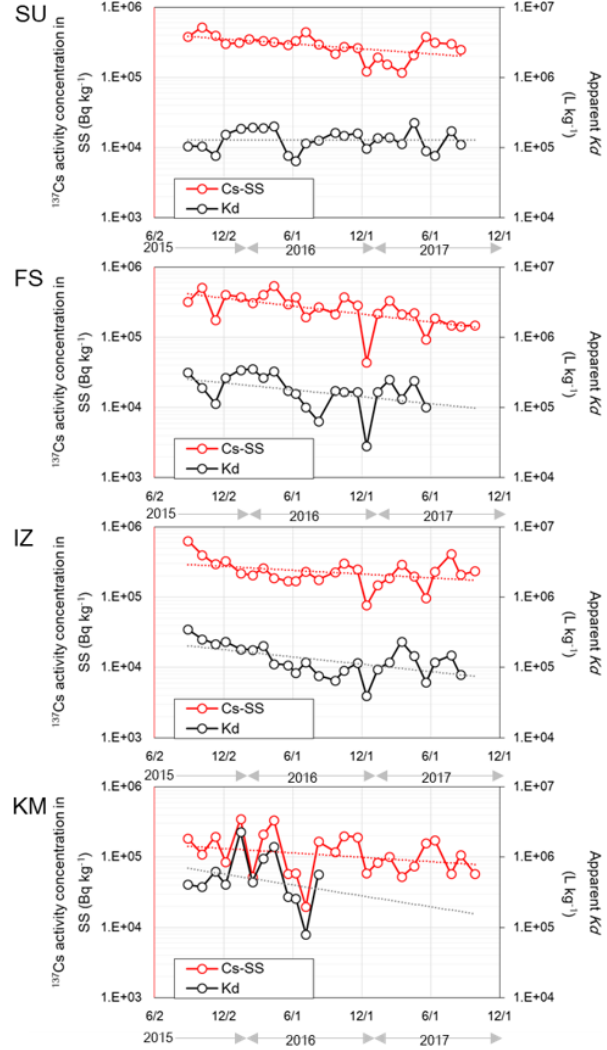
Figure 2. Temporal variations in total, particulate, dissolved 137 Cs activity concentration in the different ponds.